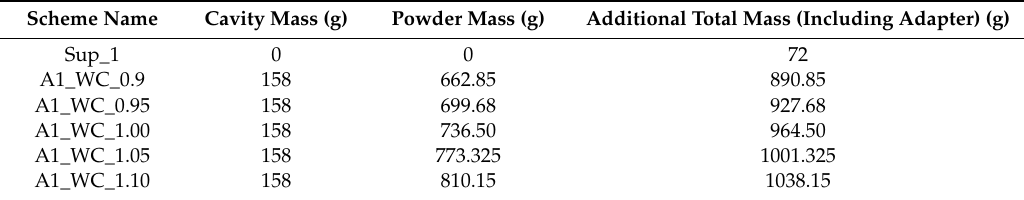
Table 10. Tungsten carbide powder mass.